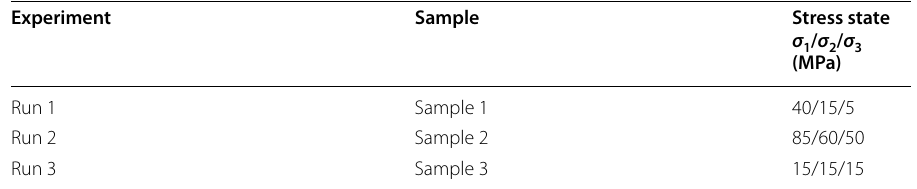
Table 2 Conditions for each borehole cooling experiment